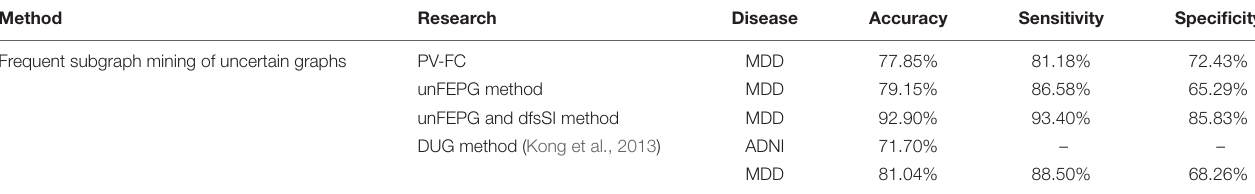
TABLE 4 | Comparison of classification performance for different